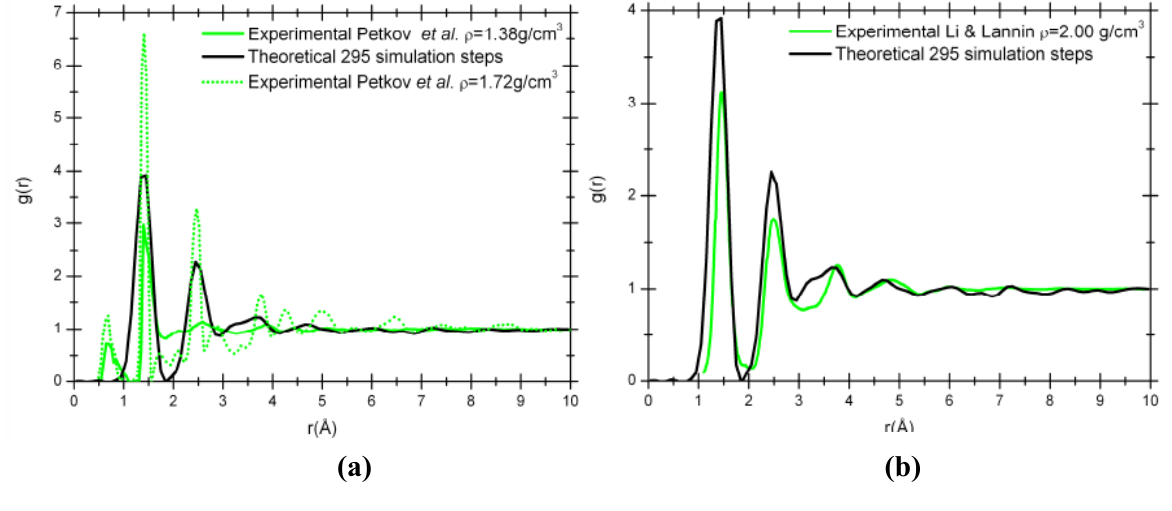
Figure 6. Comparison of our 295 step simulated RDF, g(r), with a density of 1.38 g/cm 3 (black solid line) and the experimental RDFs. (a) Experimental nanoporous carbon with a density of 1.38 g/cm 3 (green solid line) and 1.72 g/cm 3 (green dotted line). (b) Experimental amorphous carbon with a density of 2.00 g/cm 3 (green solid line).